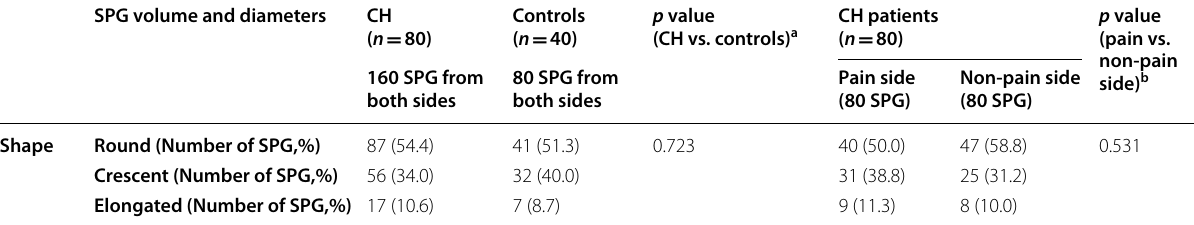
a Differences in shape of bilateral SPG between CH and non-headache healthy controls were analyzed by chi-square test, p < 0.05 was considered statistically significant b Differences in shape of SPG between pain-side and non-pain side of CH patients were analyzed by chi-square test, p < 0.05 was considered statistically significant